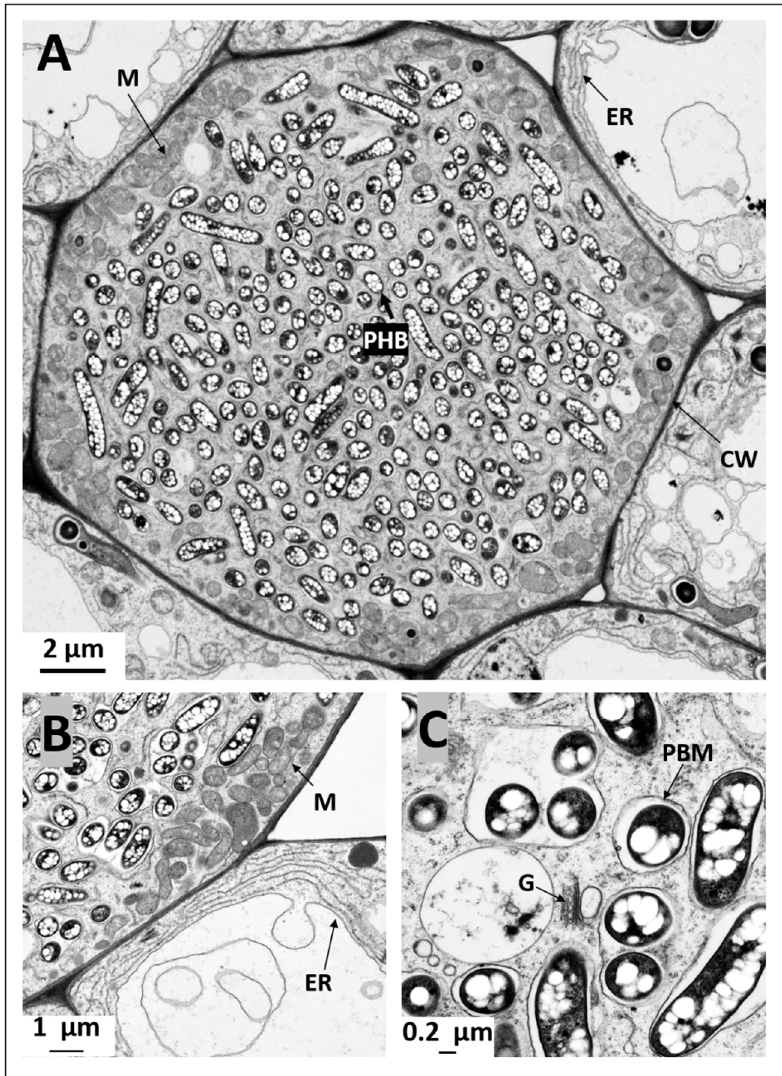
Figure 6. Transmission electron micrographs of pigeon pea nodules inoculated with S. fredii USDA191. Thin sections of pigeon pea nodules at 30 DAI were examined by transmission electron microscopy. The infected cells are filled with bacteroids ( A ). Note the presence of numerous mitochondria in the infected cells and prominent poly- β -hydroxybutyrate granules within the bacteroids ( B , C ). Extensive endoplasmic reticulum network is evident in uninfected cells ( A , B ). CW, cell wall; M, mitochondria; ER, endoplasmic reticulum; PBM, peribacteroid membrane; G, Golgi body; PHB, poly- β -hydroxybutyrate.